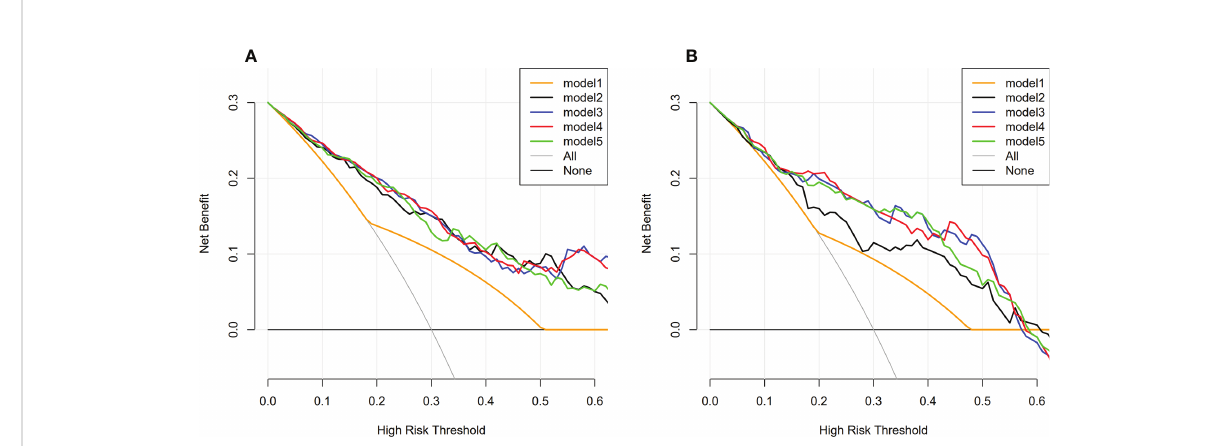
FIGURE 8 Decision curve analysis of model 1-5 in training and validation dataset. (A) Decision curve analysis of model 1-5 in training dataset; (B) Decision curve analysis of model 1-5 in validation dataset; The y-axis represents the net bene fi t. The x-axis represents the threshold probability. Model 2- 5 had higher net bene fi ts than Model 1, within a range of reasonable threshold